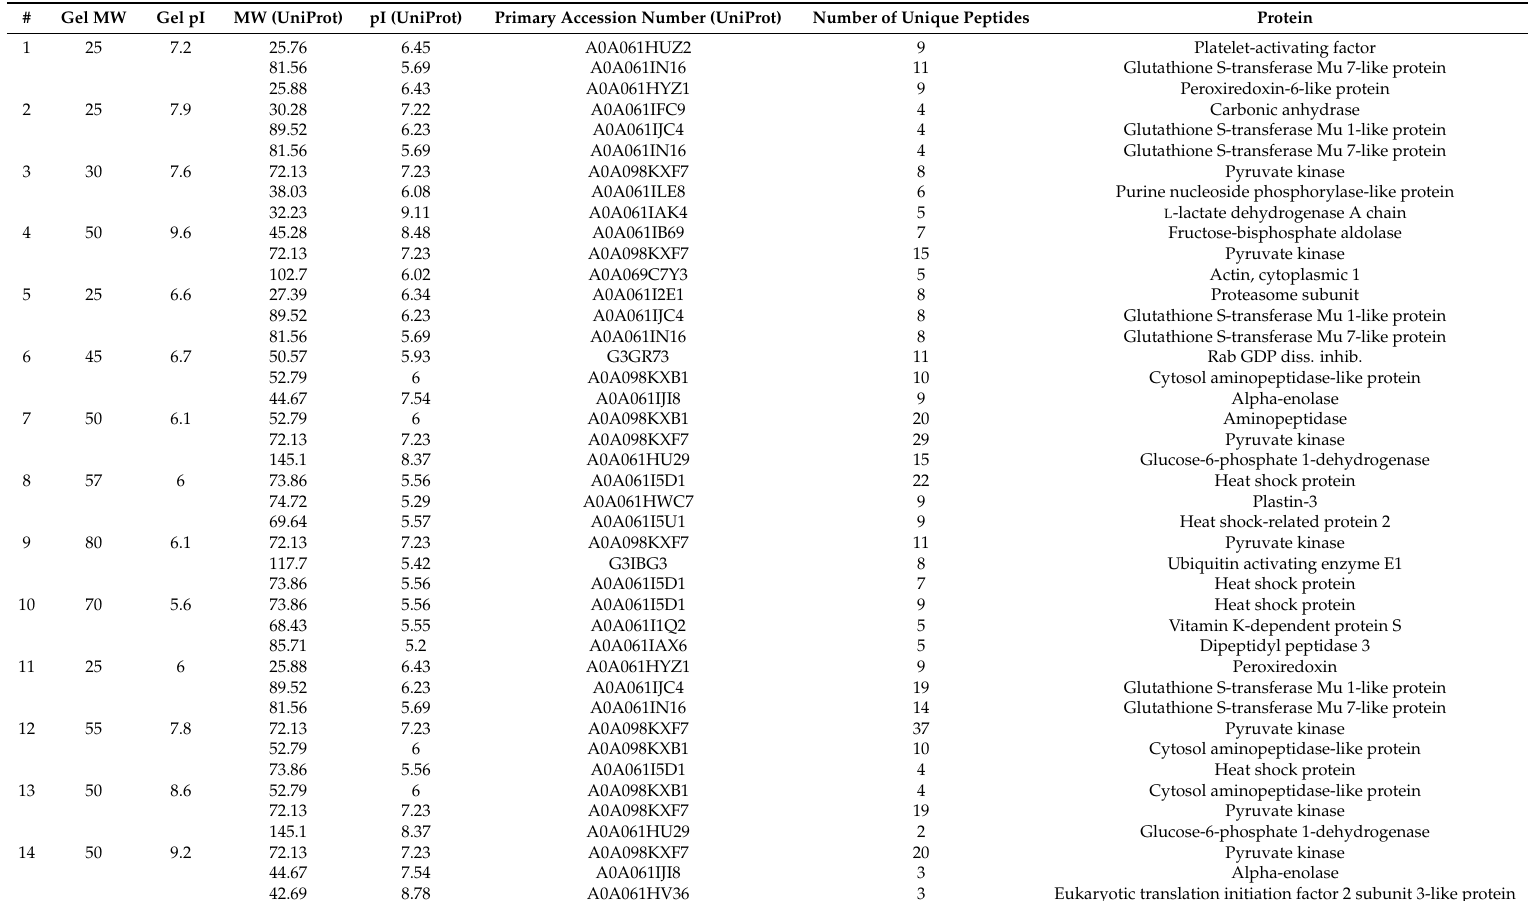
Table A1. Peptides and their corresponding proteins identified via LC-MS/MS in spots of 2D gel of the broth. Molecular weight (MW) and isoelectric point (pI) of the unmodified full length protein according to